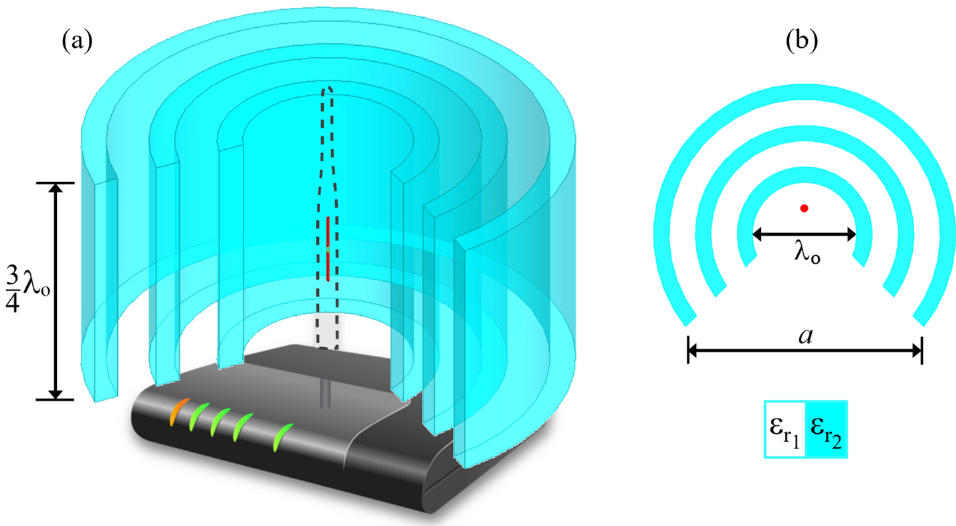
Figure 1. ( a ) Schematic representation of the proposed three layer dielectric structure for applications in 802.11 based wireless networks. The geometry is based on the H-plane radiation of AP antennas. ( b ) A top view of the quasi-cylindrical Bragg reflector with a gradual